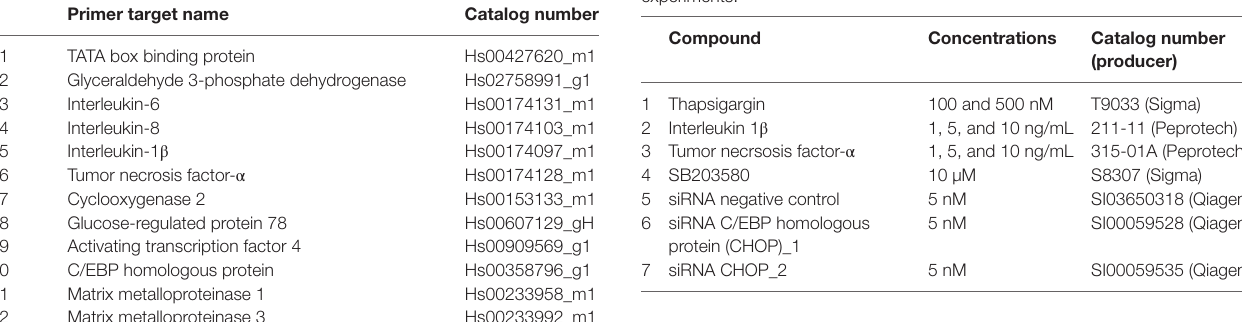
TaBle 2 | Chemical compounds and siRNAs used in the cell culture experiments.